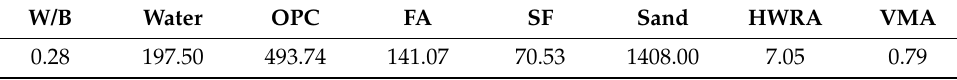
Table 2. Mix proportions for rheological property and pumping tests (Unit: kg/m 3 ).